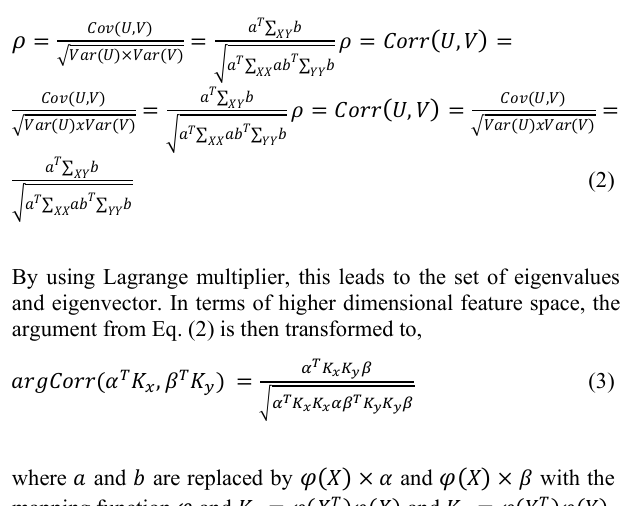
Figure 1. Polynomial least square regression Figure 2 about how to determine the Gaussian weighting distribution function.